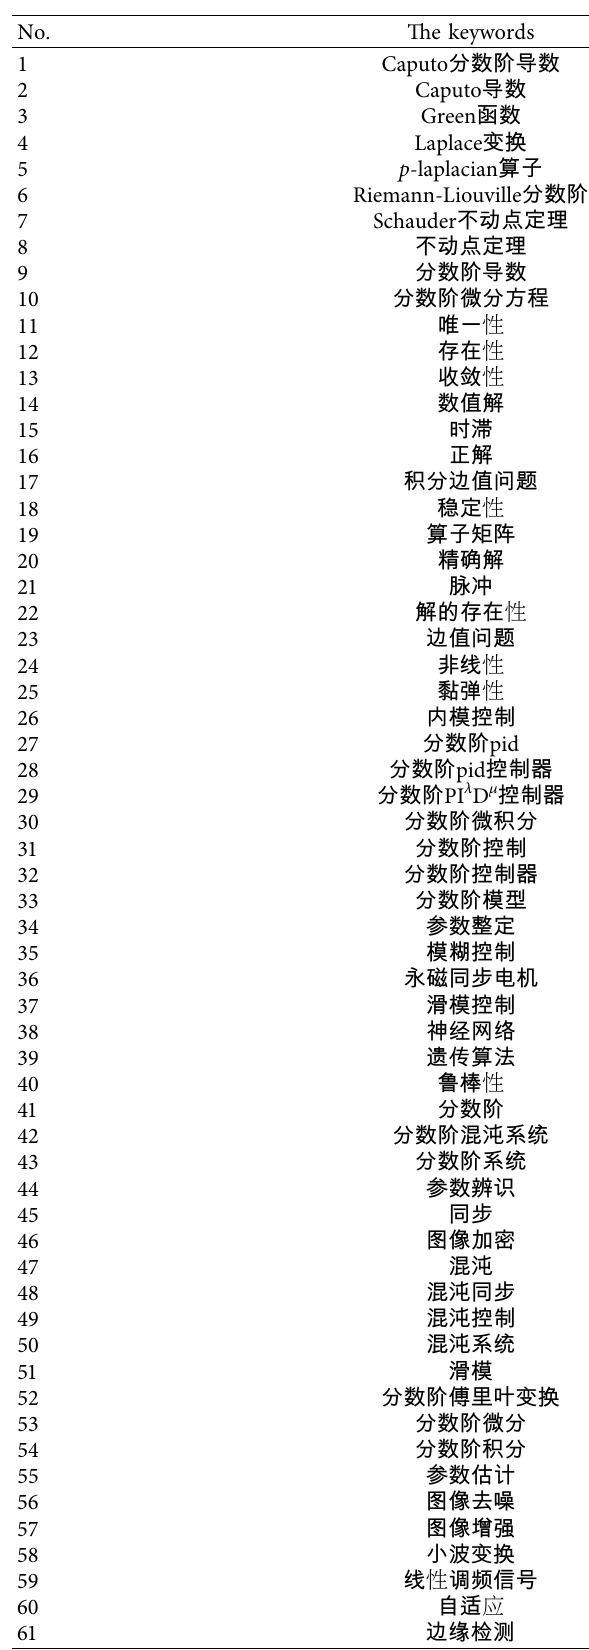
Table 3: Translation of keywords in Figures 4 and